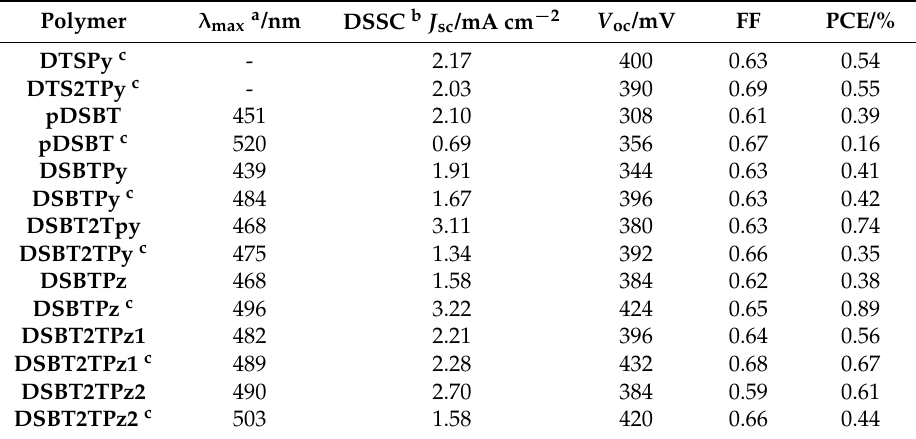
Table 2. Polymer absorption maximum and DSSC